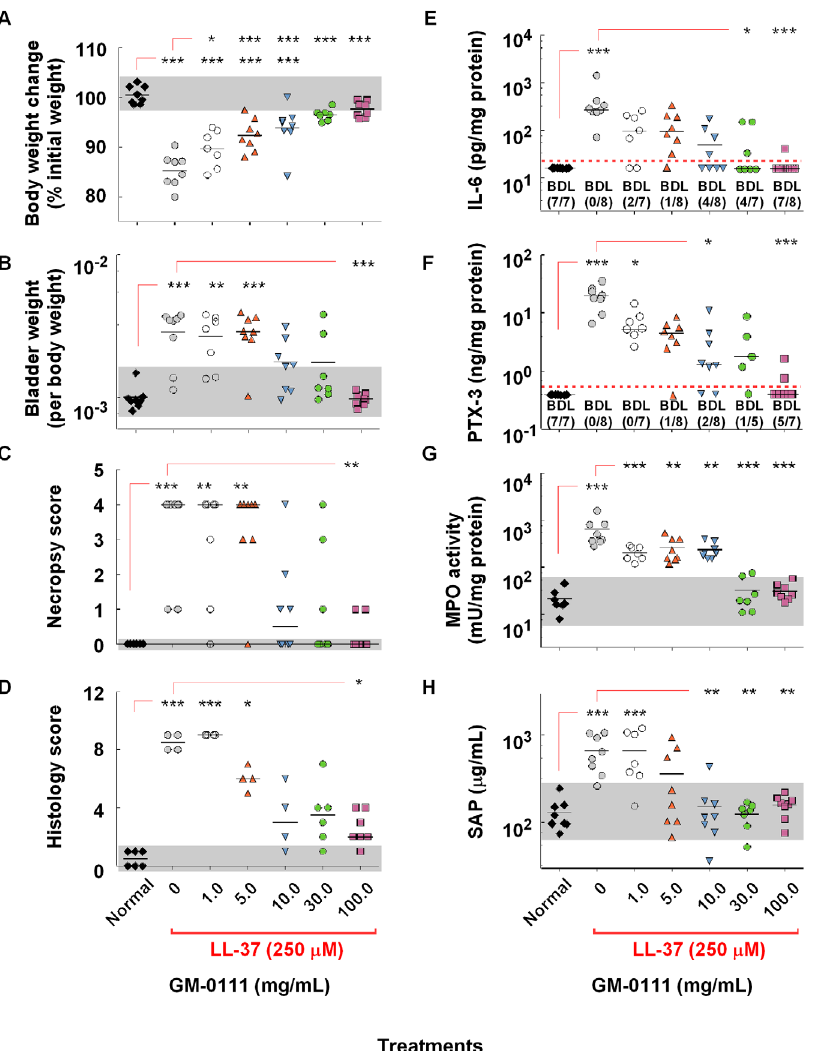
Figure 5. LL-37 instillation leads to local and systemic inflammatory changes and GM-0111 reduces the inflammatory effects of LL- 37. The animals treated with LL-37 show decreased body weight gain (A), increased bladder weight (B), gross anatomical changes in the bladder (C), severity of inflammatory changes in histological observations (D), and the bladder concentration of IL-6 (E), PTX-3 (F), MPO activity (G) and blood level of SAP (H). * p , 0.05, ** p , 0.01, and *** p , 0.001 compared to Normal or PBS pre-treatment/LL-37 treated control. Black horizontal bars are mean or median (necropsy and histology scores) values. BDL and the values in the parenthesis represent the number of samples that fell below the detection limit (dotted red line) of the ELISA out of the total samples tested (see Data Analysis in Materials and Methods section for details). Gray area represents the range of values found in normal animals.